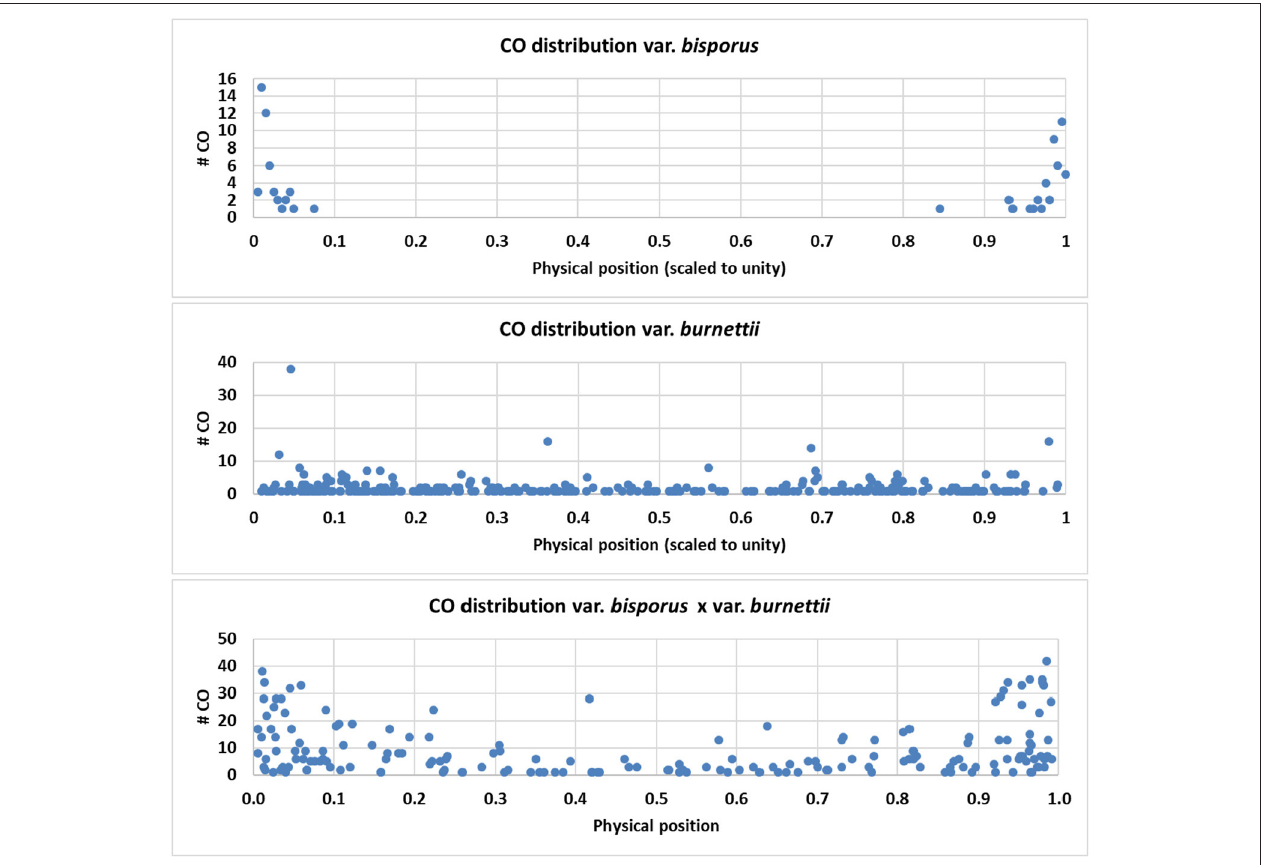
FIGURE 5 | CO distribution of the parental lines Horst U1 (var. bisporus ), 119/9 ( var. burnettii ), and the intervarietal hybrid HBT03. CO positions were calculated as described in MandM, scaled according to a standard chromosome length of one, and subsequently plotted against the physical position on the standard chromosome. A clear contrasting phenotype is seen in the parental lines and an intermediate pattern in the intervarietal